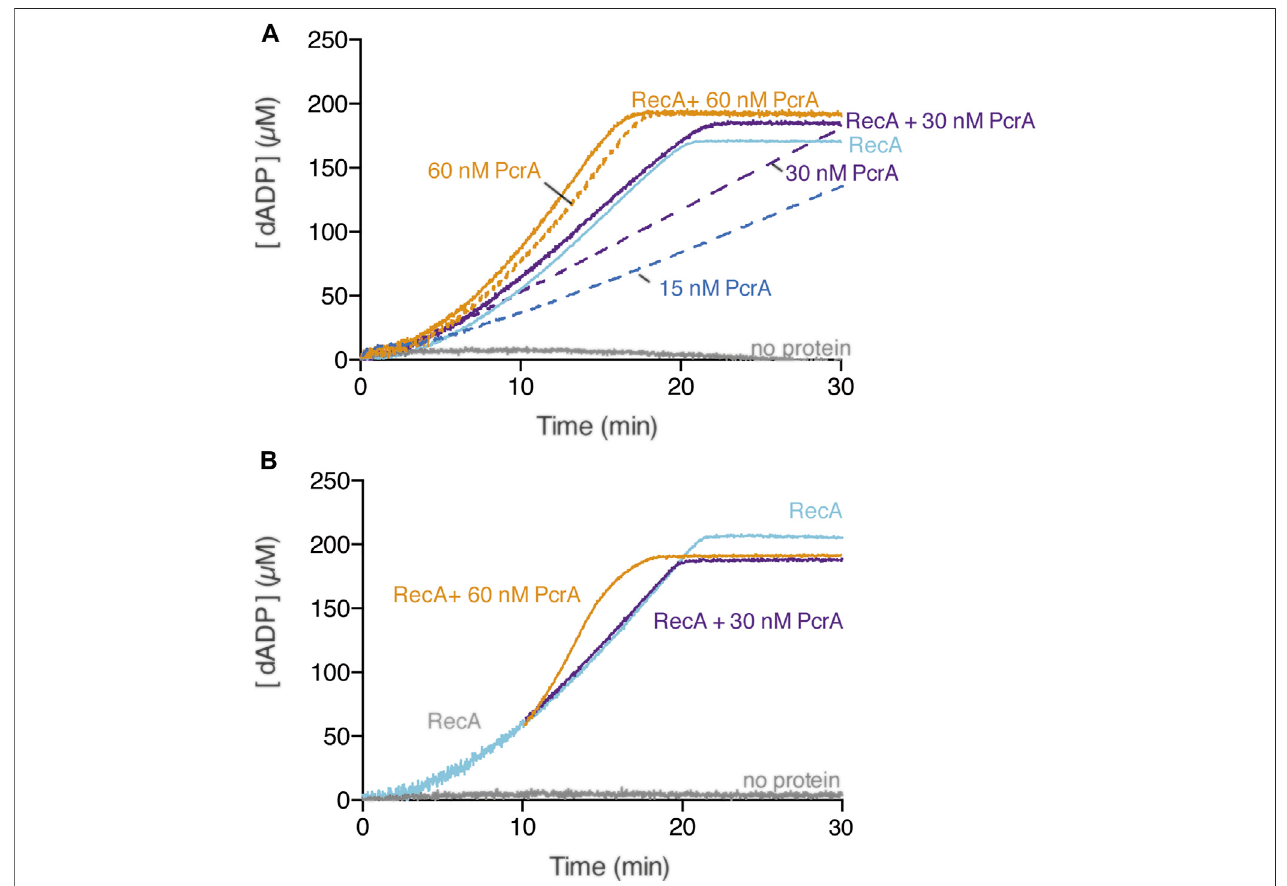
FIGURE 4 | Multiple PcrAs inhibit RecA-mediated dATP hydrolysis. (A) PcrA (15 – 60 nM), RecA (800 nM), or both proteins were incubated with cssDNA (10 μ M in nts) in buffer A containing 5 mM dATP (A) ; or RecA and cssDNA were pre-incubated (10 min, 37 ° C) in buffer A containing 5 mM dATP, and then increasing PcrA concentrations were added (B) . The grey line denotes the control reaction corresponding to the dATPase assay in the absence of any protein, and the broken lines represent the presence of only PcrA at the indicated concentration (A,B) . The dATPase activity was measured (30 [or 20] min, 37 ° C). Representative graphs are shown here, and the determined K cat is described in the